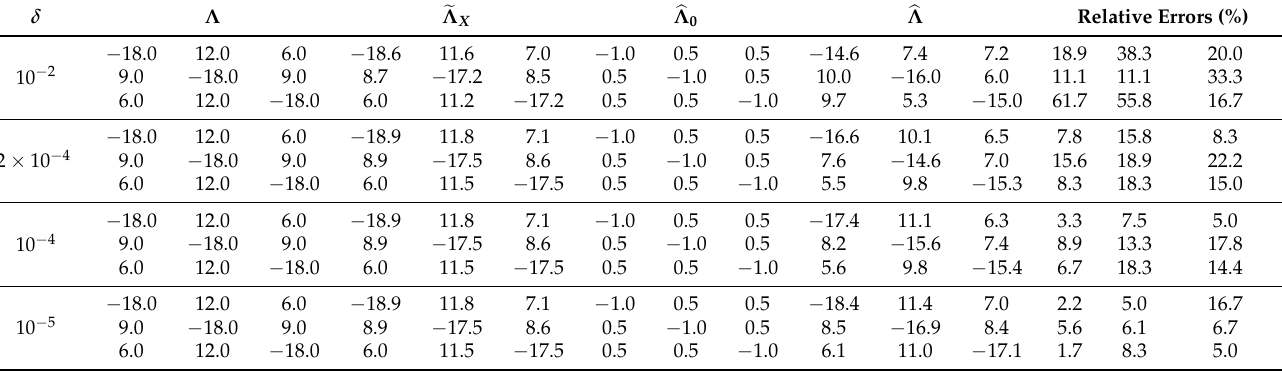
Table 1. Identification results of the TIM Λ